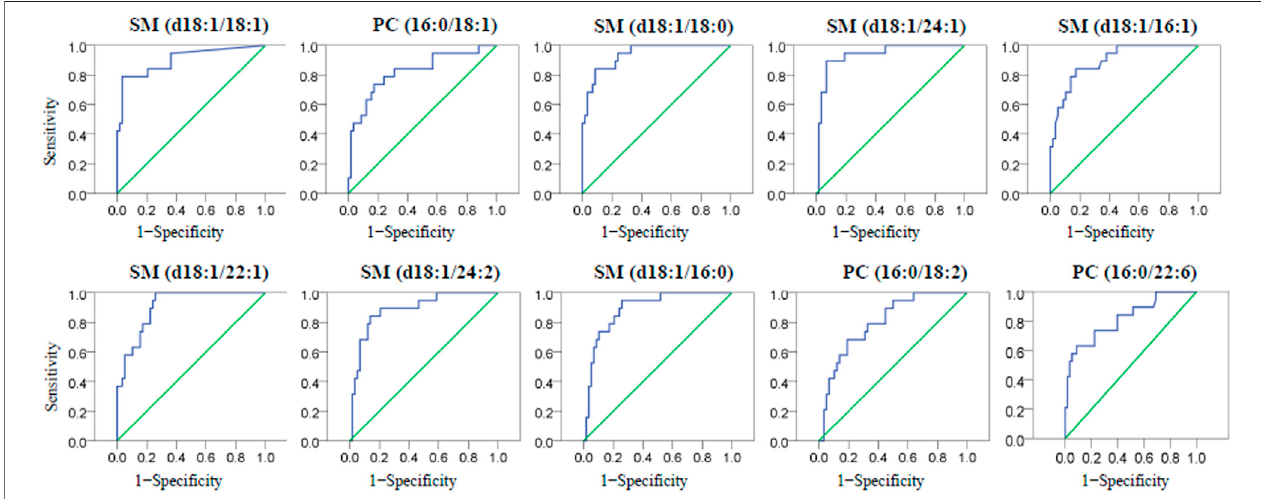
FIGURE 4 | The ROC curves of then one-way ANOVA validated PL biomarkers for the diagnosis of CE from LAA